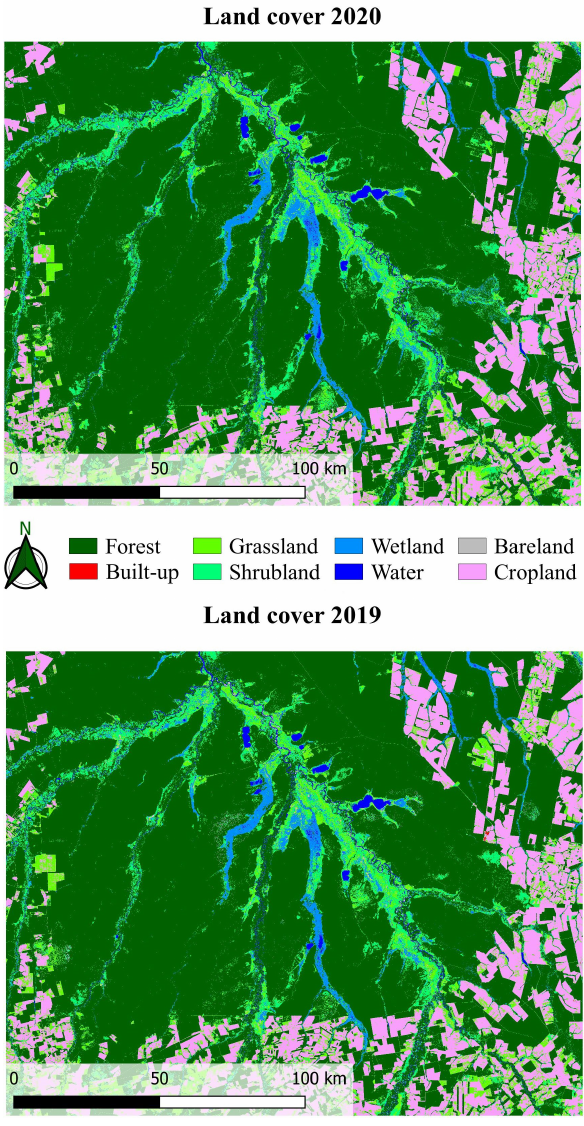
Figure 5: Land cover for 2020 (up) and 2019